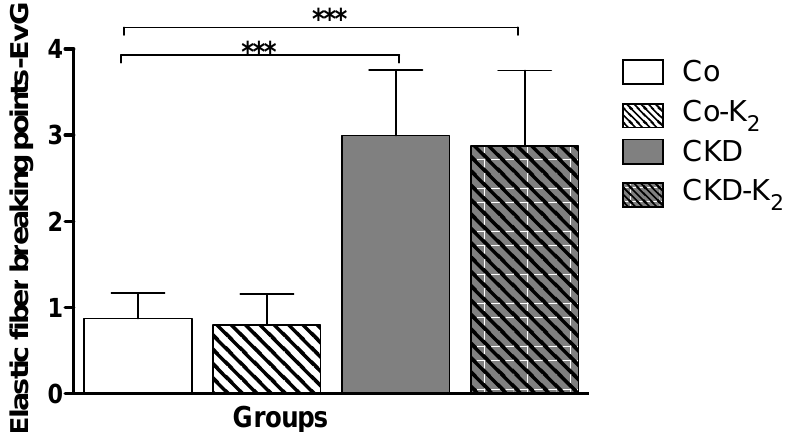
Figure 7. Elastic fiber breaking points. Elastica van Gieson (EvG) staining of aortic tissue samples with focus on elastic fiber breaking points. CKD animals display significantly more elastic fiber breaking points compared to Co animals. Co = control group; Co-K 2 = MK-7 supplemented control group; CKD = 5/6 nephrectomized group; CKD-K 2 = MK-7 supplemented 5/6 nephrectomized group. Significant differences: *** p < 0.001.